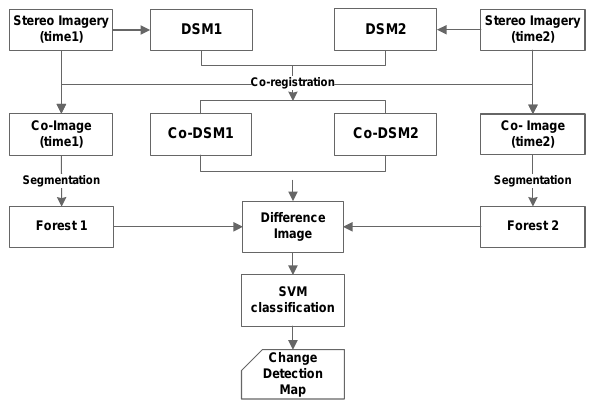
Figure 6. The pixel gray value histogram of forest area Figure 5. Forest change detection procedure proposed in this As displaying in Figure 7, the black mask stands for the vegetation paper. cover, while the connected red crosses are the segment unites. The vegetation cover rate of the Unit-A and Unit-B are 3/7 and 3/8 respectively. The comparison of the segments is processed based on this vegetation cover rate and the height information from